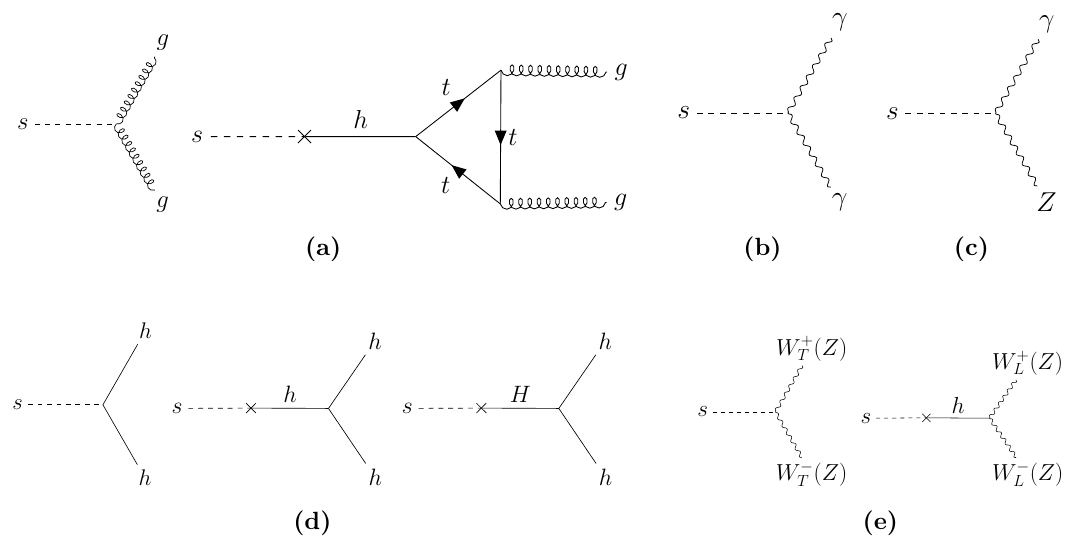
Figure 3. Feynman diagrams for main sgoldstino decay